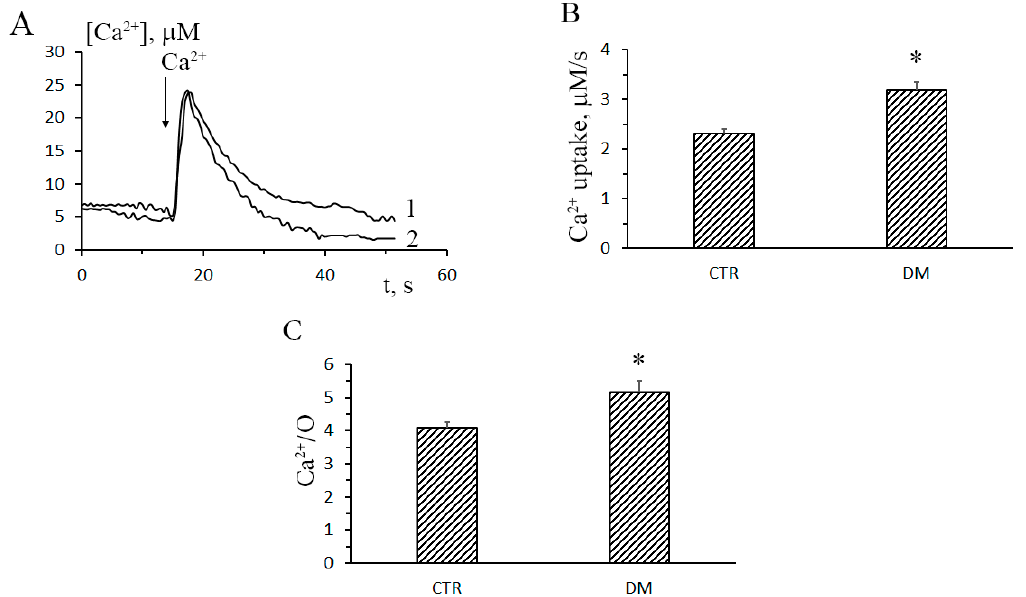
Figure 1. Diabetes leads to increased rates of Ca 2 + uptake by rat liver mitochondria. ( A ) The dynamics